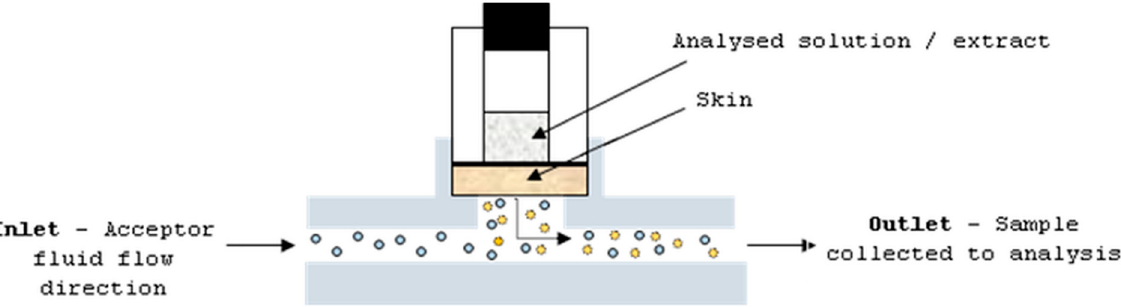
Figure 6. Diffusion cell apparatus.